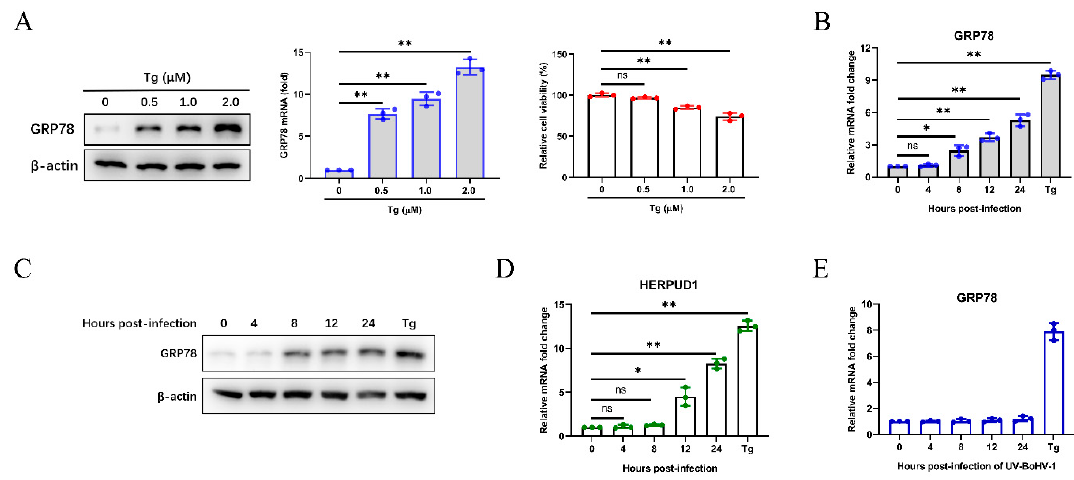
Figure 1. BoHV-1 infection triggers ER stress in MDBK cells. ( A ) The expression of GRP78 in MDBK cells treated with di ff erent concentrations of ER stress inducer Tg for 24 h was detected by western blotting and qPCR, and the cell counting kit 8 (CCK-8) assays were performed to analyze the viability of the MDBK cells. ( B ) A time-dependent increase of GRP78 mRNA levels was revealed by qPCR in MDBK cells infected with BoHV-1 at an MOI of 0.1 at di ff erent time points (0 to 24 h) after infection. Tg (0.5 µ M) was used as a positive control for ER stress. ( C ) The GRP78 protein levels were measured by western blotting at 0 to 24 hpi, and Tg (0.5 µ M) was used as the positive control. ( D ) qPCR analysis of HERPUD1 mRNA levels in MDBK cells at 0 to 24 h after BoHV-1 infection. ( E ) qPCR analysis of GRP78 mRNA levels in MDBK cells infected with UV-inactivated BoHV-1 or treated with Tg (0.5 µ M). The graph shows the levels of GRP78 or HERPUD1 normalized against β -actin ( A , B , D , E ). The mean ± SD of data from three independent experiments are shown; * p < 0.05, ** p < 0.01.